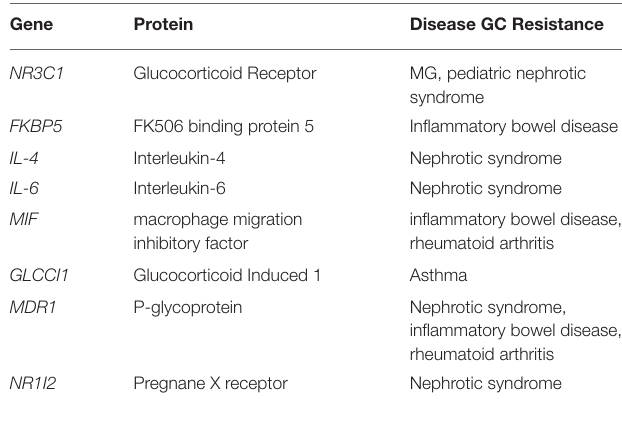
TABLE 1 | Examples of genes with single nucleotide polymorphisms associated with GC